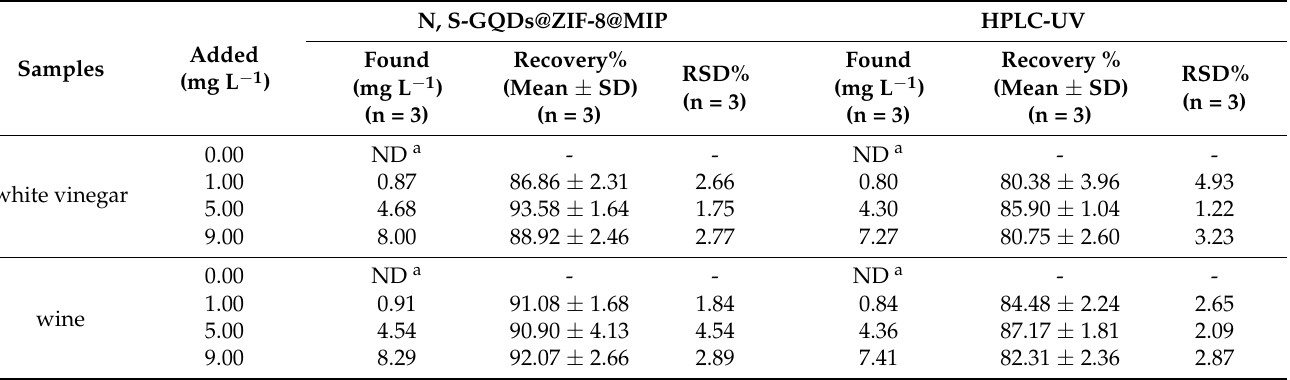
Table 1. The determination of OA-containing samples via the proposed N, S-GQDs@ZIF-8@MIP and